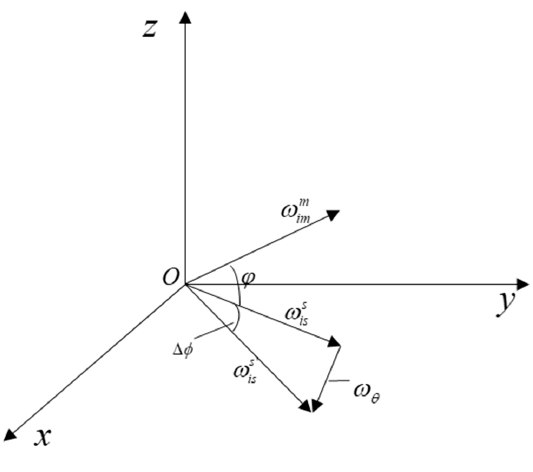
Figure 2. The relationship between ω m